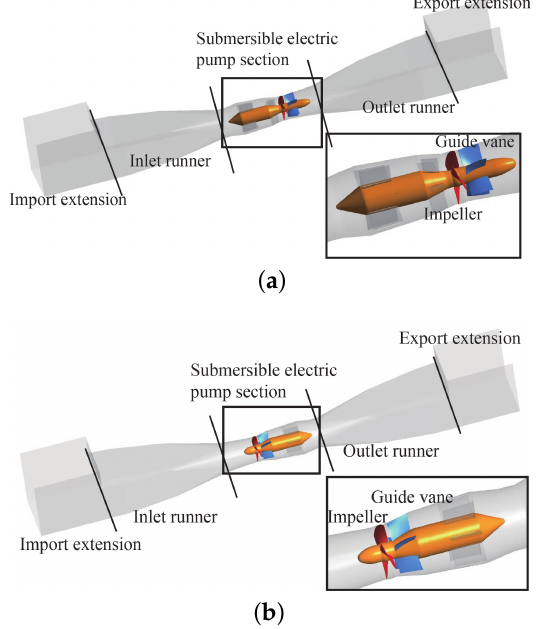
Figure 1. Three-dimensional model of submersible tubular pump device: ( a ) front-mounted scheme; ( b ) rear-mounted